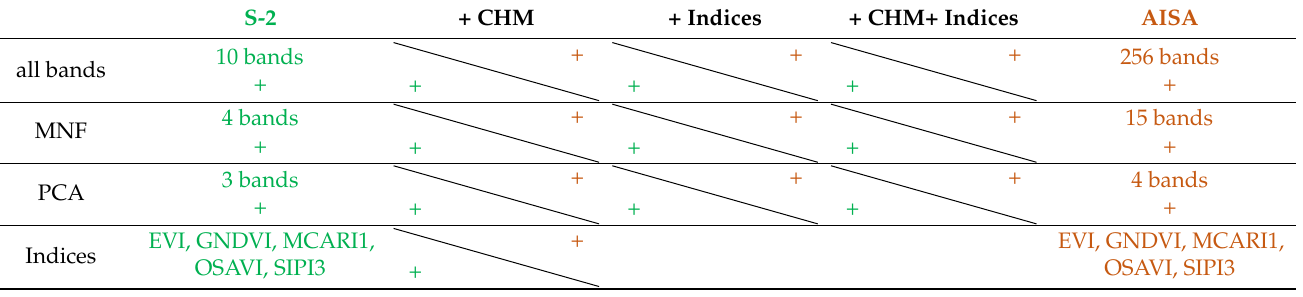
Table 4. The 28 scenarios were tested simultaneously on Sentinel-2 and AISA processed data and supporting materials like CHM, VIs or both of them; + data sets for the Sentinel-2, + data set for the AISA, with information how many bands was used for all data, MNF, PCA and the abbreviation name for the used